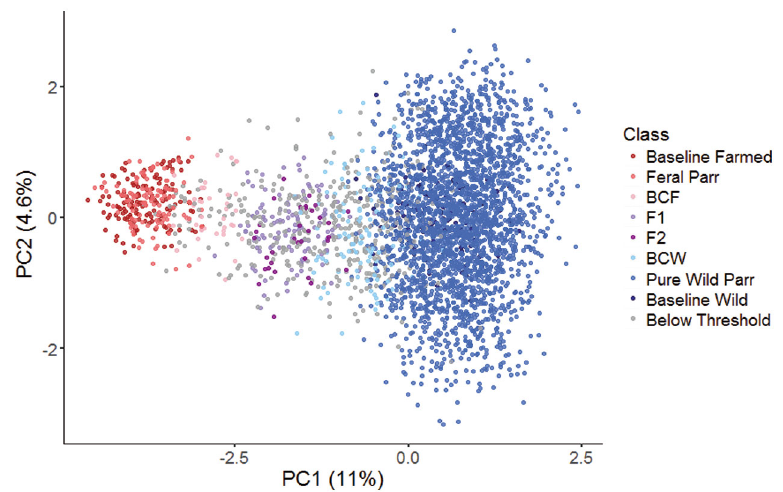
Fig. 4. Principal components analysis (PCA) of all sampled and baseline Atlantic salmon individuals, with axes indicating proportion of variance ex plained by each PC axis. Individuals are coloured according to classification in N EWHYBRIDS (Anderson & Thompson 2002), or, in the case of baseline individuals, known baseline class (see Fig. S5 in the Supplement for clustering by river of origin)